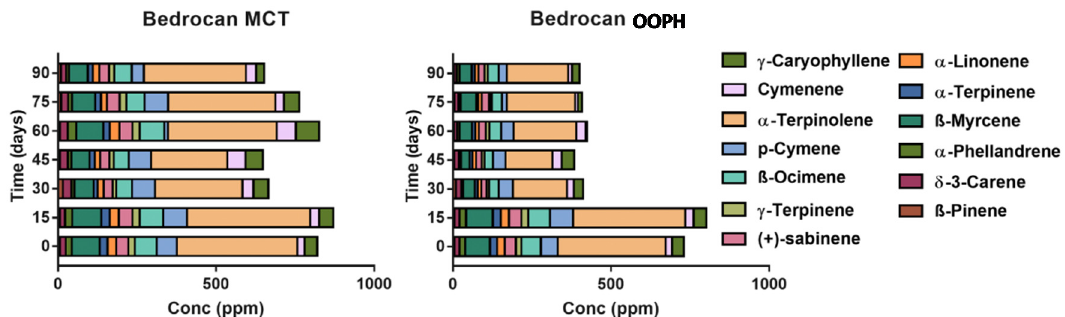
Figure 7. Concentration of the most representative terpene species (ppm) in Bediol ® oils as a function of storage time and lipid sources: PhEur-grade olive oil (OOPH) and medium-chain triglyceride (MCT) oils.